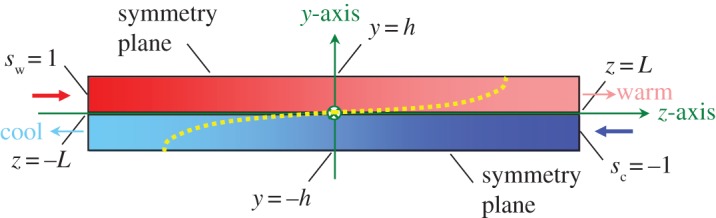
Schematic of one symmetry unit of a counterflow heat exchanger. The fluid velocity will have a peak at each symmetry plane; but there will be no heat flux across such planes. Generic profiles of velocity across the warm and cool streams of the unit are shown as yellow dots. The profile in the warm stream will be Uf(υ) while that in the cool stream is taken to be its mirror image –Uf(–υ).